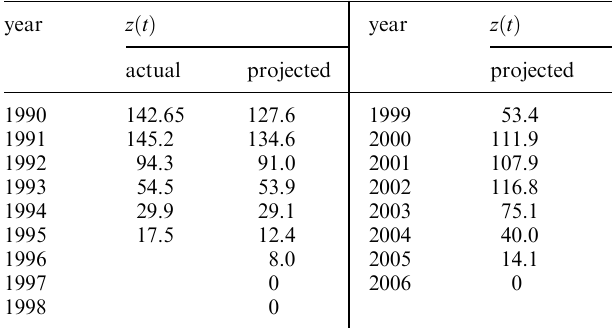
Table 5. z (cid:133) t (cid:134) 11-year projection